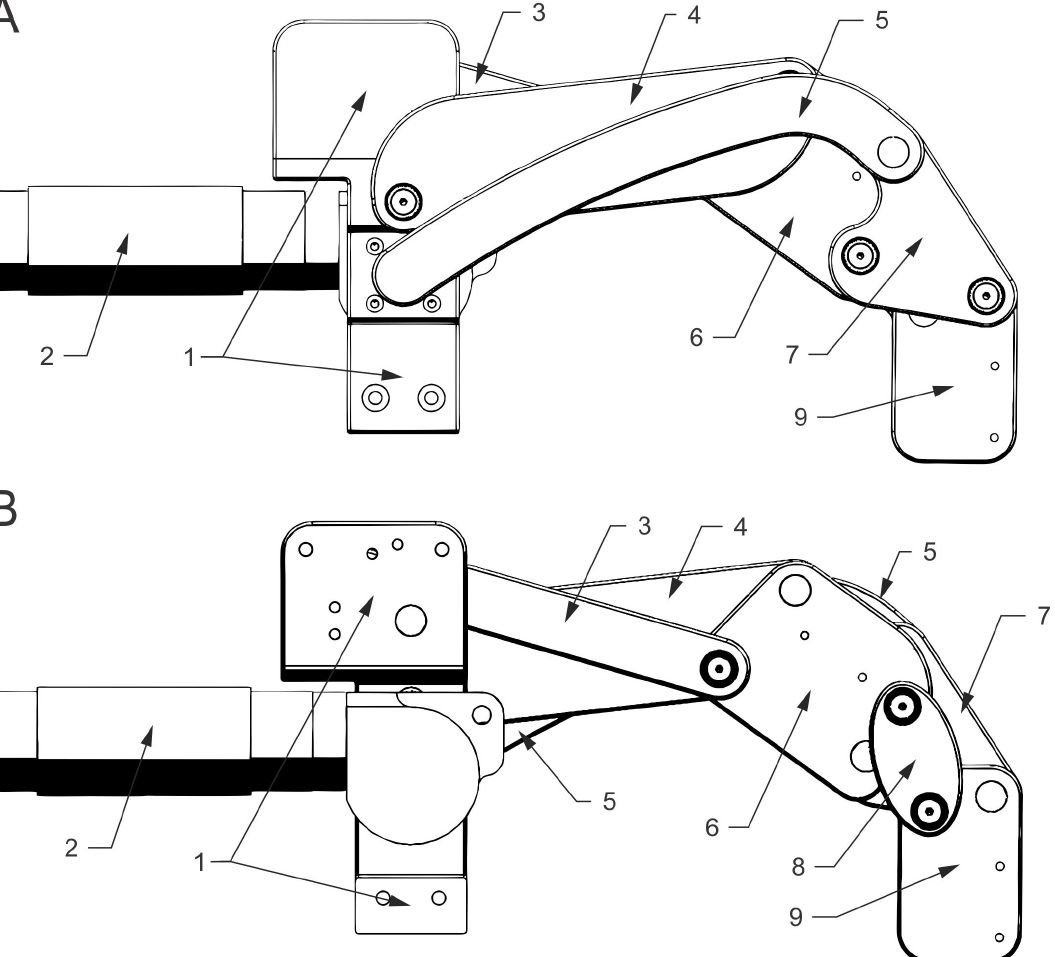
Figure 1. Sketch of the device’s mechanism, lateral ( A ) and medial ( B ) view. The numbers in the figures correspond to the following parts—1: mounting bracket, 2: actuator, 3: upper segment, 4: middle segment, 5: lower segment, 6: central segment, 7: triangular segment, 8: oval segment, and 9: end